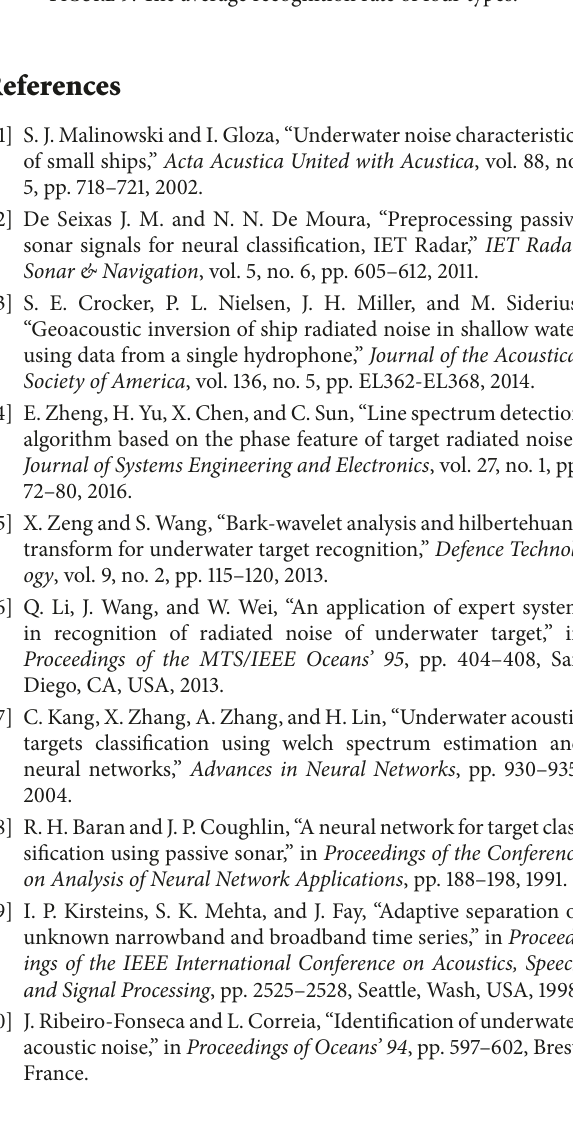
Figure 9: The average recognition rate of four